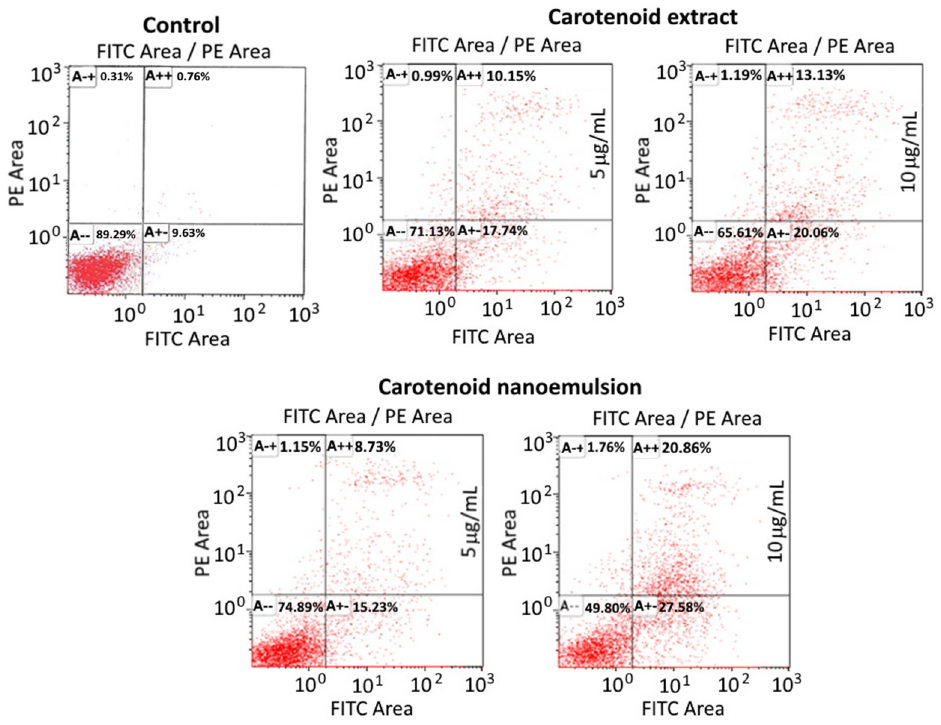
Figure 6. Apoptosis of MCF-7 cancer cell line as affected by carotenoid extracts and carotenoid nanoemulsions. Control, cells were incubated in medium only. A − +, necrosis cells; A++, late apoptosis cells, A −− , viable cells; A+ − , early apoptosis cells.